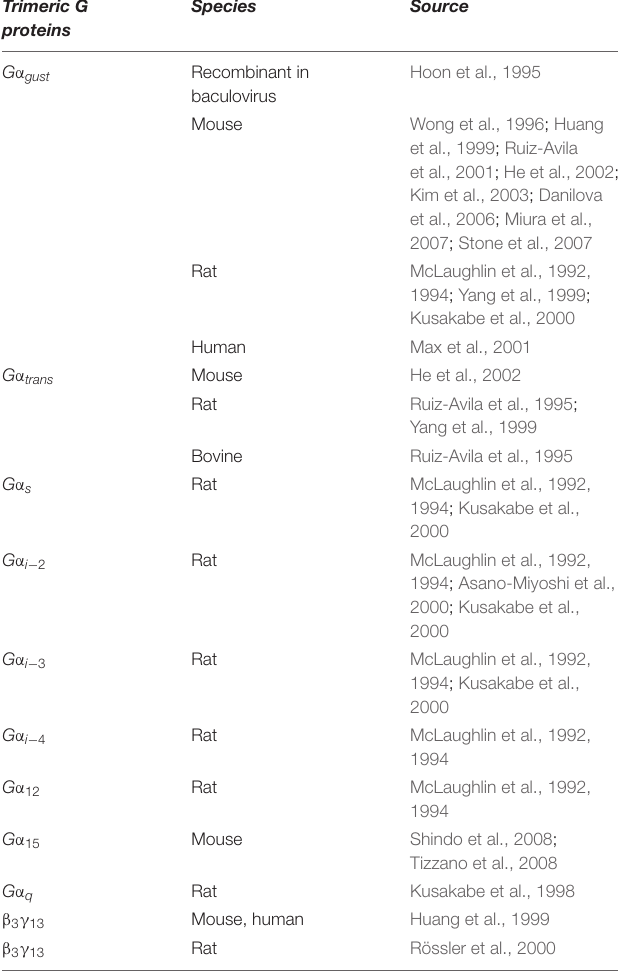
TABLE 3 | Overview of G-protein subunits expression in the taste buds. Trimeric G